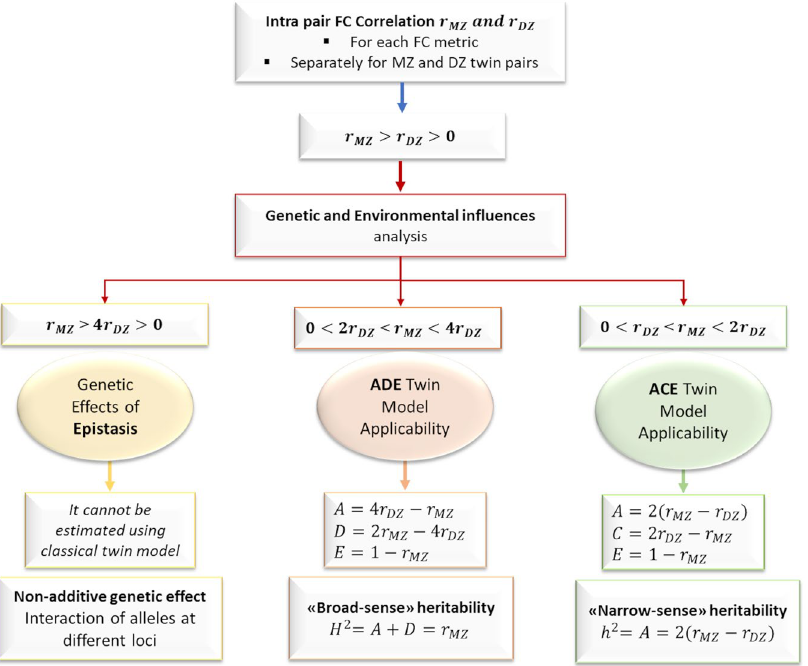
Figure 1. Schematic illustration of genetic and environmental analysis pipeline. For each FC metric, separately for MZ and DZ twin pairs, we computed the linear partial correlation coefficient between the selected feature values obtained from each twin in each pair, at net of the effects of age and sex. We obtained zygosity-specific correlations ( r MZ and r DZ ) for each FC metric at brain-, node- and link-level. Genetic and environmental analysis was performed on the FC metrics associated with r MZ > r DZ > 0 . Three main scenarios were r MZ distinguished based on r DZ ratio: ADE or ACE twin model applicability and the analysis of nonadditive genetic effect of epistasis. The estimate of “broad-sense” or “narrow-sense” heritability was extracted for the FC metrics that verified respectively ADE or ACE twin model applicability condition. FC: functional connectivity. MZ: monozygotic. DZ: dizygotic. r DZ : intra-pair phenotypic correlation in DZ pairs. r MZ : intra-pair phenotypic correlation in MZ